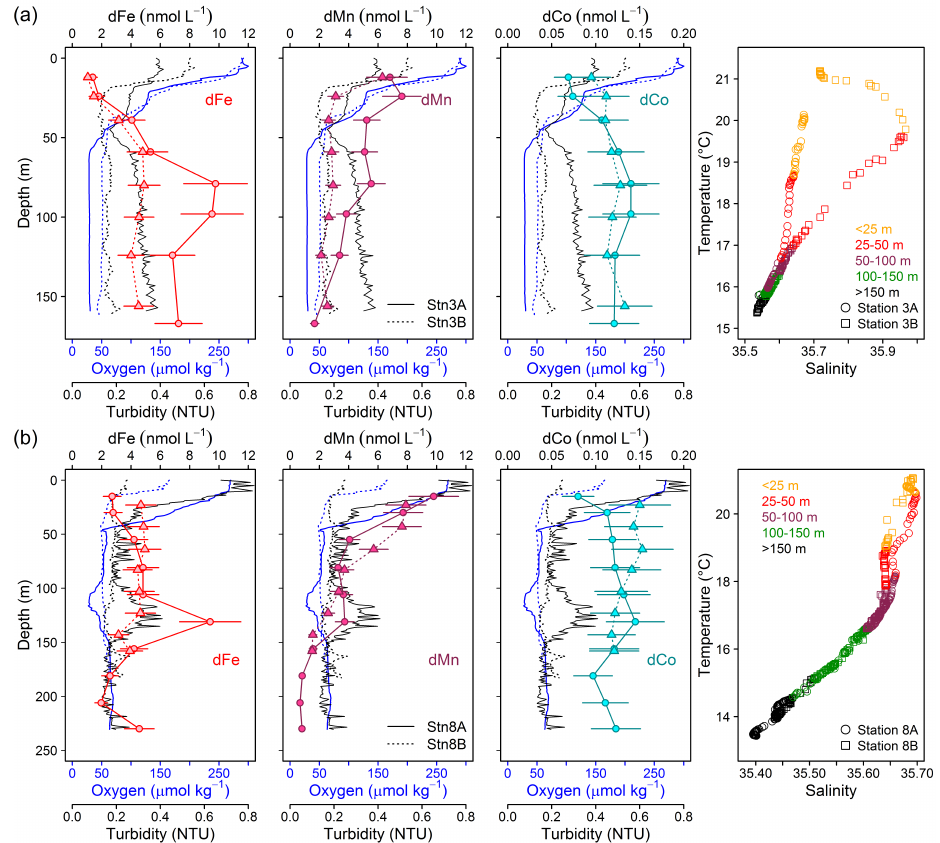
Figure 7. Repeat stations: oxygen concentration, turbidity, and dissolved trace metals (Fe, Mn, and Co) and temperature vs. salinity plots. First deployment displayed as solid line and circles and second deployment displayed as dashed line and triangles. (a) Station 3 (18.23 ◦ N, 16.52 ◦ W; 170m water depth, 9d between deployments). (b) Station 8 (18.22 ◦ N, 16.55 ◦ W; 189–238m water depth, 2d between deploy-